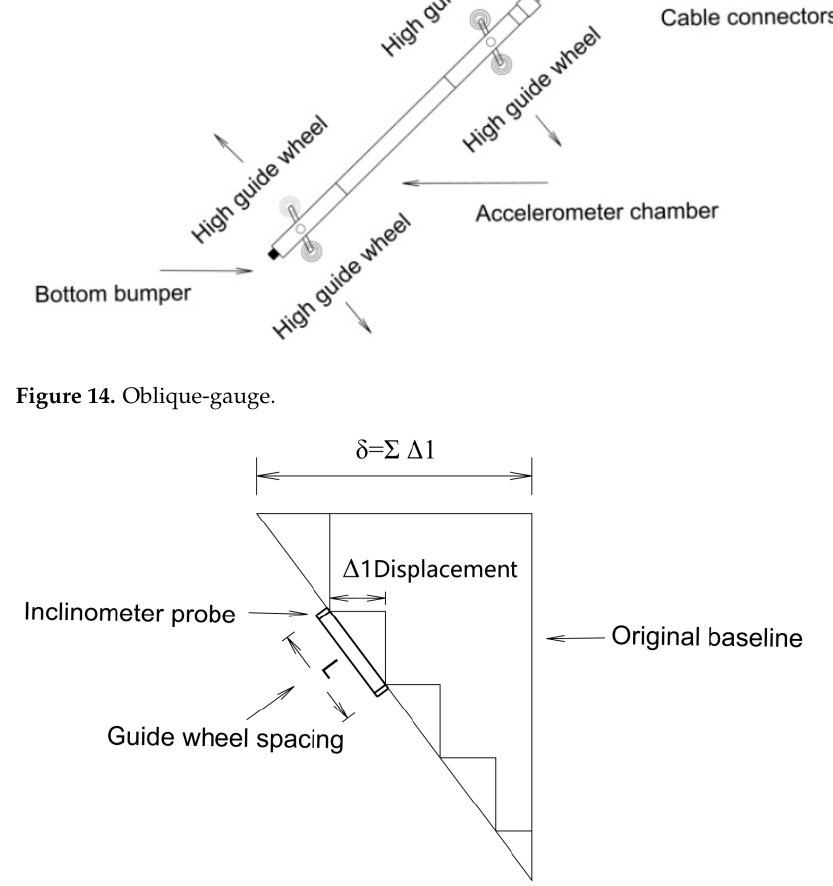
Figure 15. How inclinometers work.